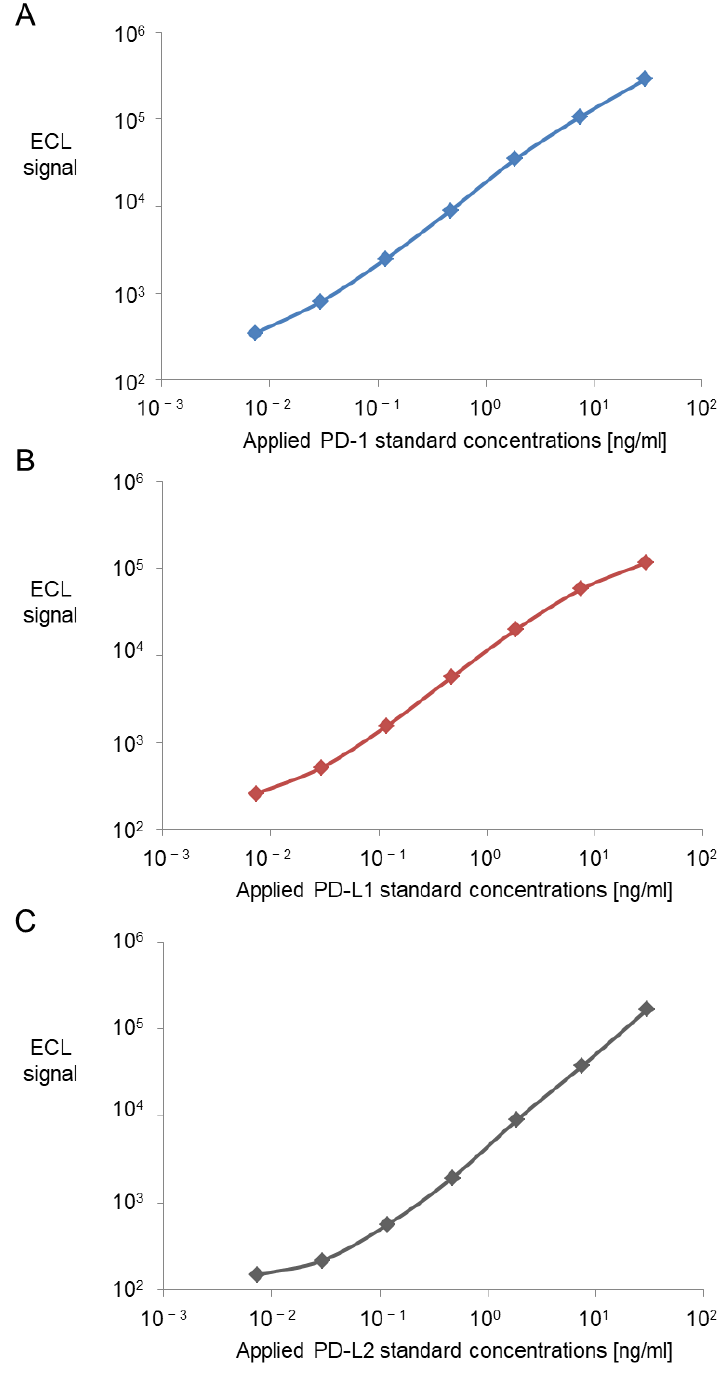
Figure 1. Standard curves of the assays for PD-1 ( A ), PD-L1 ( B ) and PD-L2 ( C ). Measured signals are plotted over a serial dilution of recombinant protein for PD-1 ( A ), PD-L1 ( B ) and PD-L2 ( C ). These serve as standard curves to quantify protein concentrations in following experiments. The calibration curves used to calculate antibody concentrations are established by fitting the signals from the calibrators to a 4-parameter logistic (or sigmoidal dose-response) model with a 1/Y2 weighting. ECL: Electrochemiluminescence .